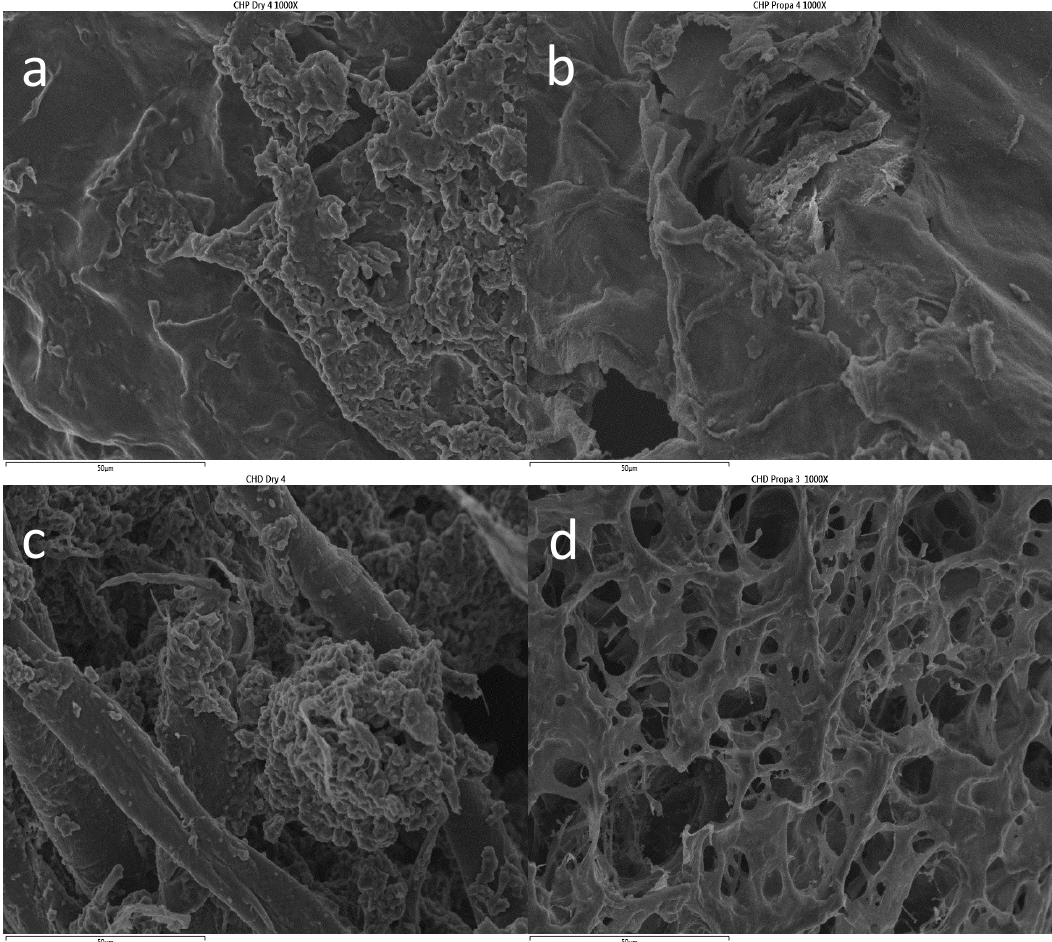
Figure 3. Scanning electron micrographs of CS-P ( a , b ) and CS-DNA ( c , d ) before ( a , c ) and after ( b , d ) GP loading. ×1000 magnification. Scale = 50 µm.